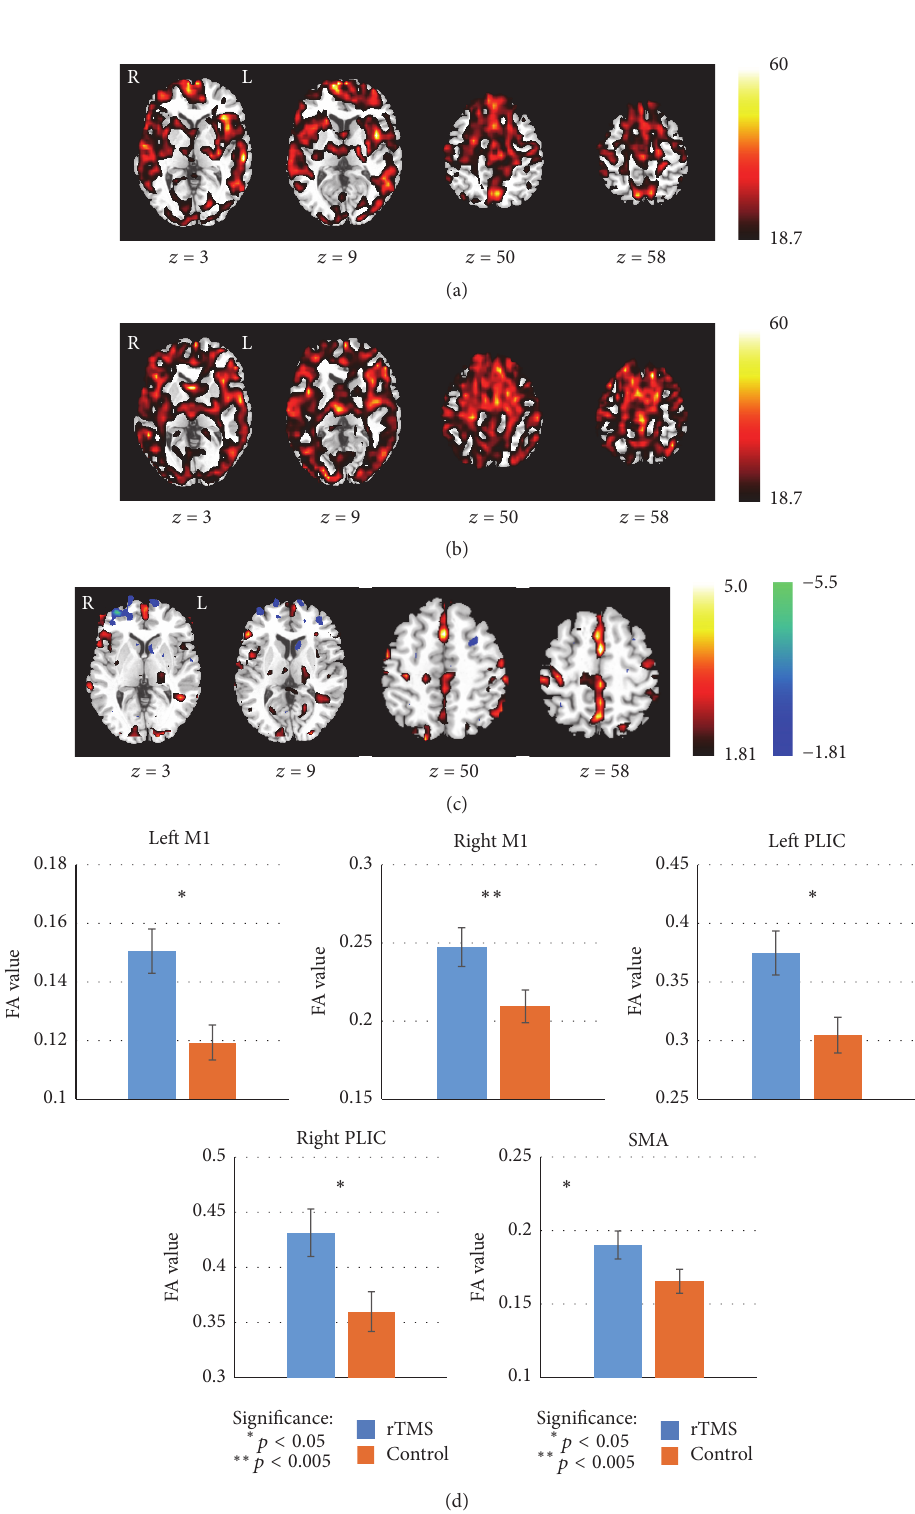
Figure 3: Comparison of FA maps between patients of RT and CT groups after treatment. The FA results of one-sample 𝑡 -test for stroke patients of post-CT (a) and post-rTMS treatment (b). (c) Significantly changed brain areas are superimposed on the che2bet hemisphere of the Montreal Neurological Institute template brain in the three-view drawing ( 𝑝 < 0.05 ). The warm and cold tones separately indicate the increased and decreased FA value of RT. (d) Bars represent the mean FA values. Vertical bars indicate estimated standard errors. Compared with the CT, the mean FA value showed a significant increase after rTMS treatment in bilateral posterior limb of internal capsule (PLIC), primary motor area (M1), and supplementary motor area (SMA) in